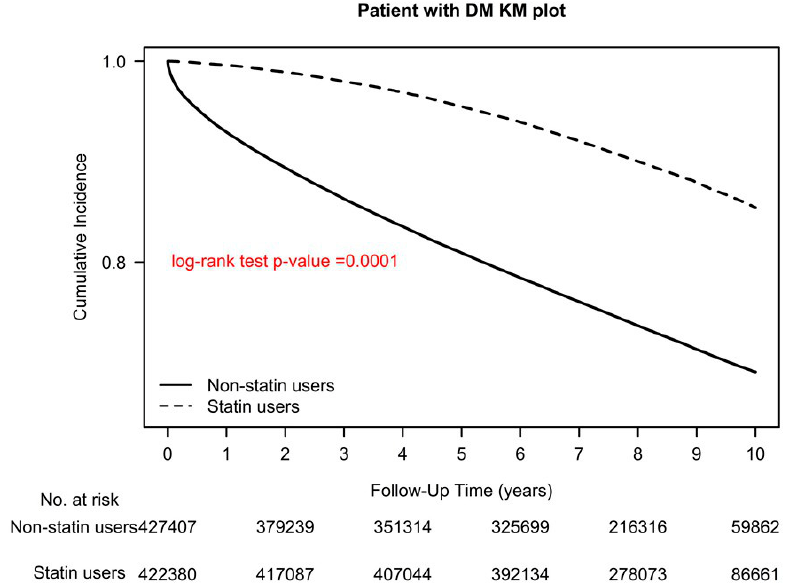
Figure 4. Kaplan–Meier overall survival curves of patients with type 2 diabetes who used and did not use statins.